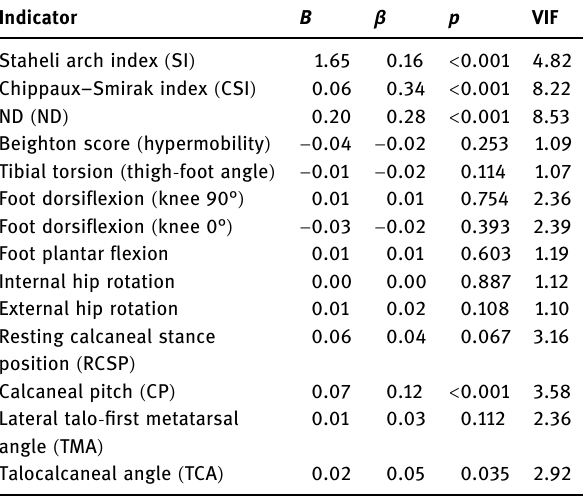
Table 5: Comparison of study indicators as potential predictors of FPI: linear regression analysis